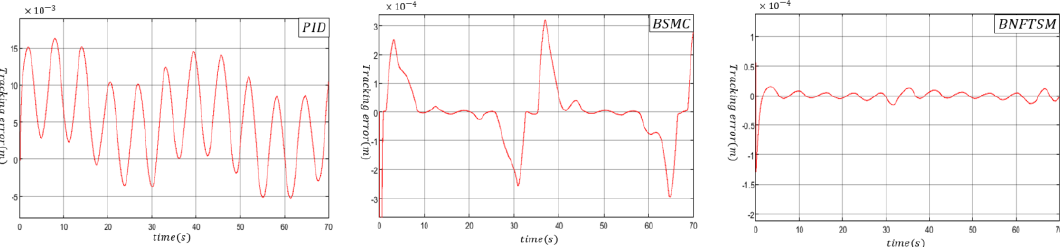
Figure 5. Tracking error curves of three controllers under variable load force of 4000sin (𝑡)N .